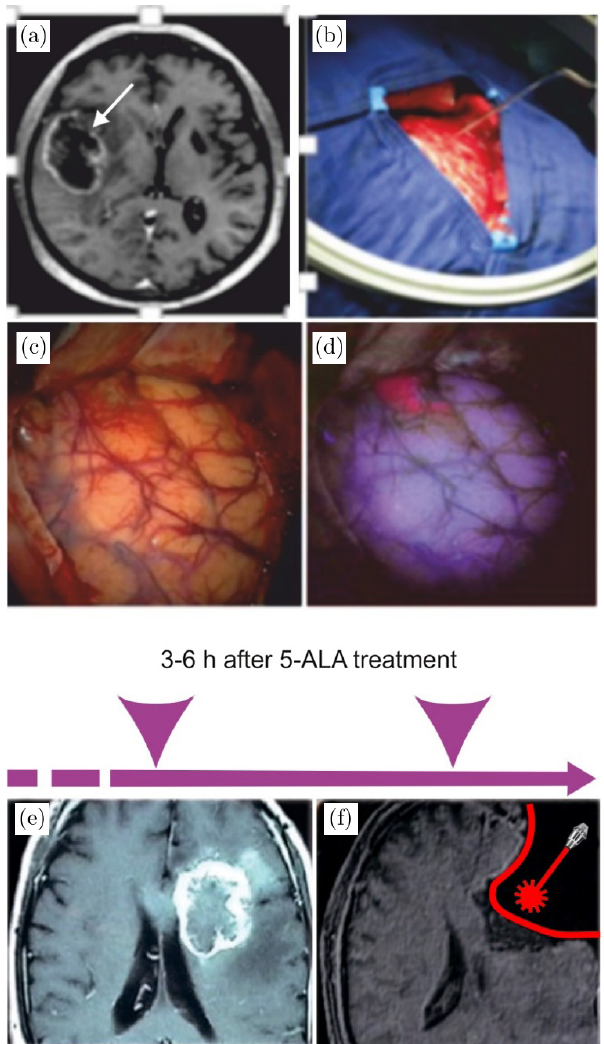
Fig. 2. The °uorescence guided resection of GBM in patient: (a) magnetic resonance imaging (MRI) of glioblastoma (arrowed); (b) preparation of surgical area; (c) the surface of brain after craniectomy; (d) speci¯c °uorescence of 5-ALA in ultraviolet 3 – 6 h after 5-ALA administration per os; (e and f) PDT of GBM, where e — MRI of GBM and f — schematic illustration of post-surgical PDT of GBM. Panels (a) – (d) pre- sented with the permission of Herbert Stepp, University Hos- pital of Munich, Germany. Panels (e) and (f) were adapted from J. Akimoto, \Photodynamic Therapy for Malignant Brain Tumors," Neurol Med Chir (Tokyo) 56, 151 – 157,